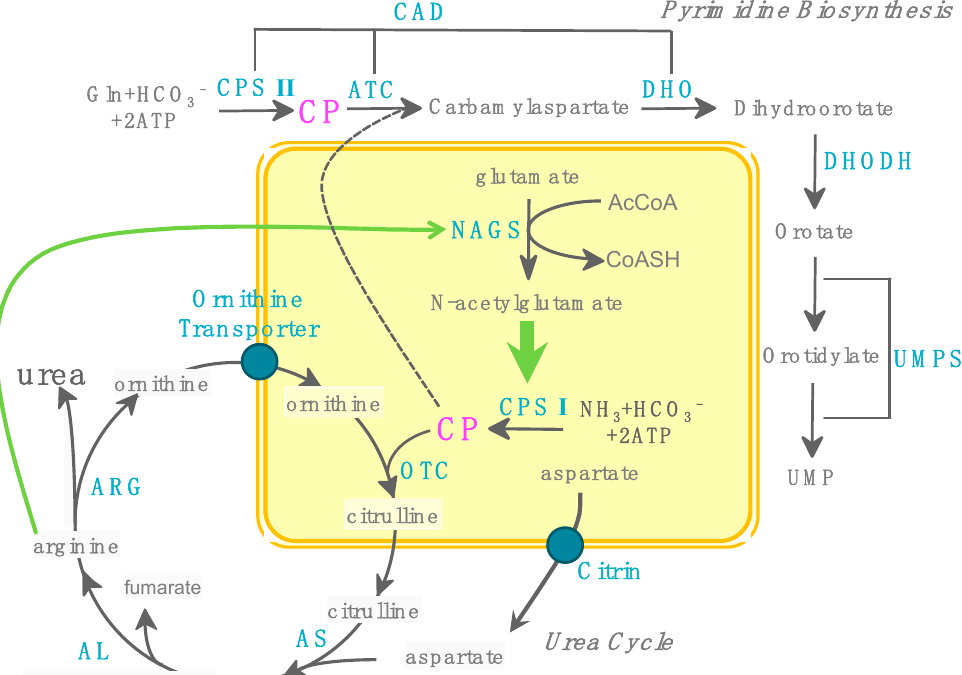
Figure 8. Urea cycle and pyrimidine de novo biosynthesis pathway. In mitochondria, N -acetyl-glutamate synthase (NAGS) generates N -acetylglutamate to activate CPS I to initiate the urea cycle. The CP generated by CPS I combines with ornithine to form citrulline by OTCase. Citrulline is transported out of the mitochondria to continue the last three steps by argininosuccinate synthase (AS), argininosuccinate lyase (AL), and arginase (ARG) to complete the urea cycle. Pyrimidine biosynthesis starts with the formation of CP from glutamine (Gln) by CPS II. CP reacts with aspartate to form carbamyl aspartate by ATCase (ATC), followed by cyclization by dihydroorotase (DHO) to form dihydroorotate. In humans, a single multifunctional polypeptide, CAD (CPS II, ATC and DHO) located in the cytosol, catalyzes the first three steps. Dihydroorotate dehydrogenase (DHODH) catalyzes the formation of orotate from dihydroorotate. Uridine monophosphate synthase (UMPS), a bifunctional cytosolic enzyme, completes the last two steps of pyrimidine biosynthesis to result in UMP formation. CP accumulation in the mitochondrial matrix will spill over to the cytosol to enter CAD to cause the elevation of orotate and increase pyrimidine biosynthesis. Enzymes are shown in cyan. Green arrows indicate activation of CPS1 by N -acetylglutamate (NAG) and NAGS by arginine. The dashed arrow indicates spillover of CP from mitochondria into cytoplasm in OTC deficiency.